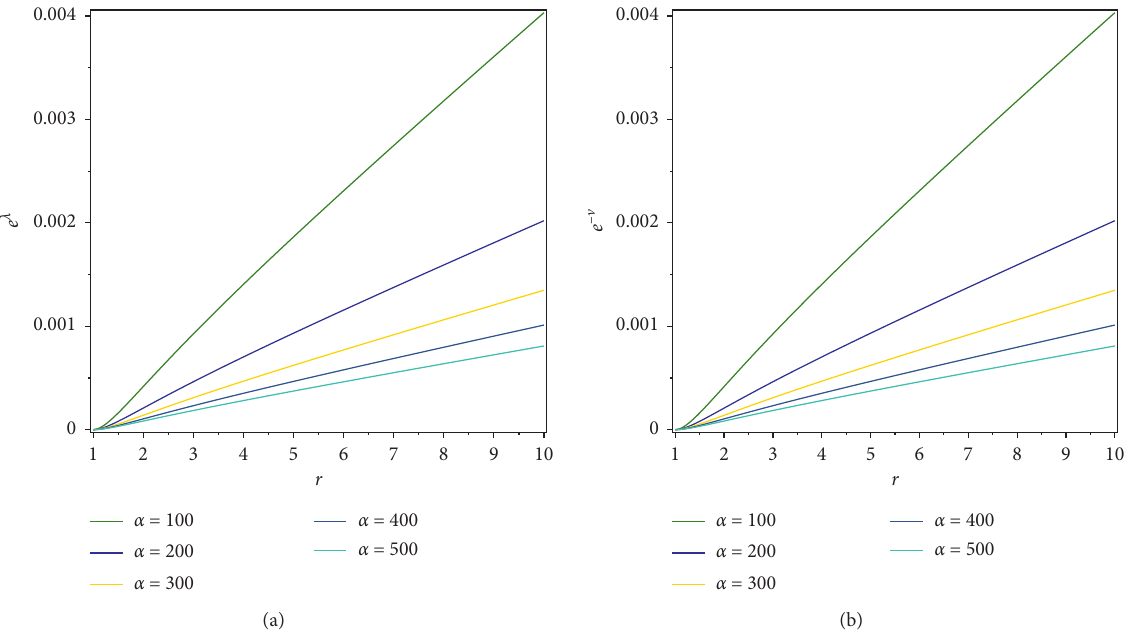
Figure 1: Plots of metric potentials corresponding to r .